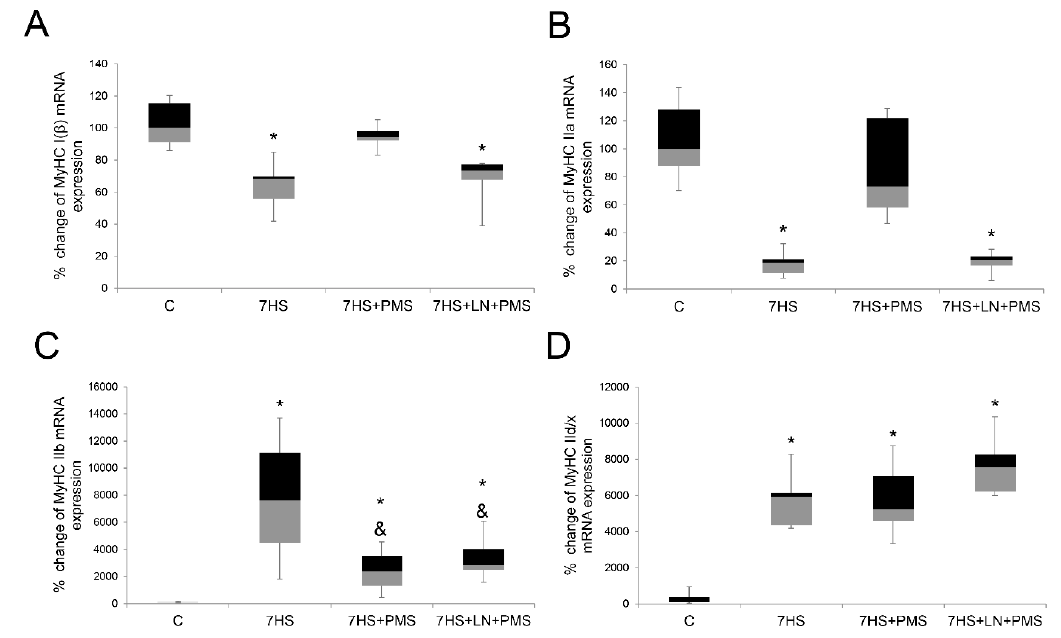
Figure 3. Expression levels of MyHC I( β ) ( A ), MyHC IIa ( B ), MyHC IIb ( C ), MyHC IId/x ( D ) mRNAs in rat soleus muscle in the control group (C), 7-day hindlimb-suspended group (7HS), 7-day hindlimb suspended group with plantar mechanical stimulation (7HS + PMS), 7-day hindlimb suspended group with plantar mechanical stimulation+ L-NAME introduction (7HS + LN + PMS). Data are shown as % of the control group. *—significant difference from the control group. &—significant difference from 7HS group ( p < 0.05). Box plots show 25–75 percentiles and median values and the whiskers represent the minimum and the maximum; n = 8/group.